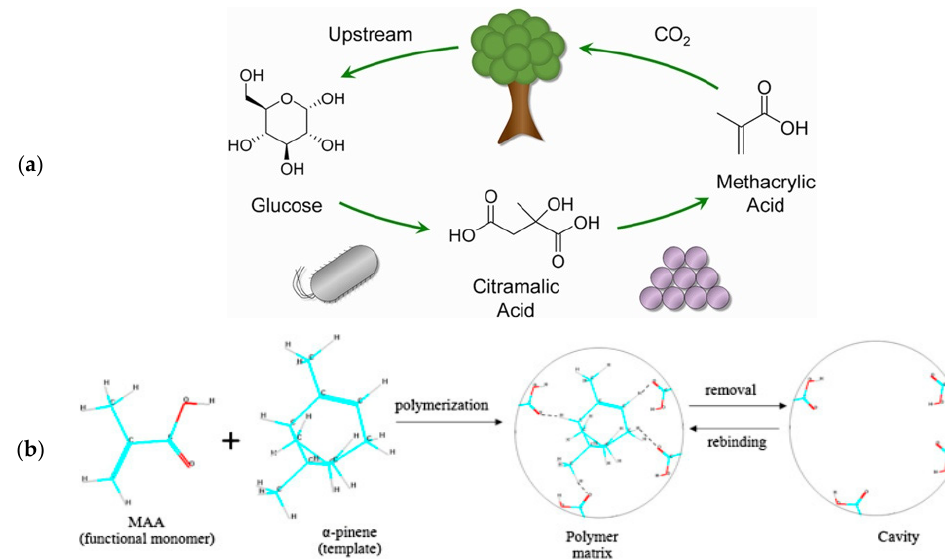
Figure 5. ( a ) Scheme of the hybrid fermentation and thermocatalysis to produce methacrylic acid (MAA) from glucose. Reprinted with permission from ref. [113]. Copyright 2021 American Chemical Society. ( b ) Illustration of molecular imprint polymer (MIP) concept made of MAA. Reprinted with permission from ref. [112]. Copyright 2013 Elsevier.